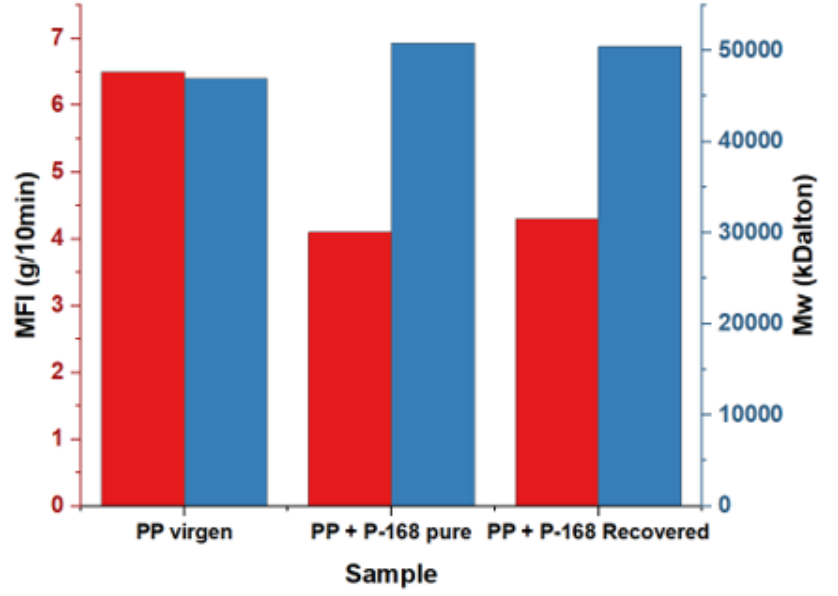
Figure 15. MFI PP + P-168 pure and PP + P-168 recovered.